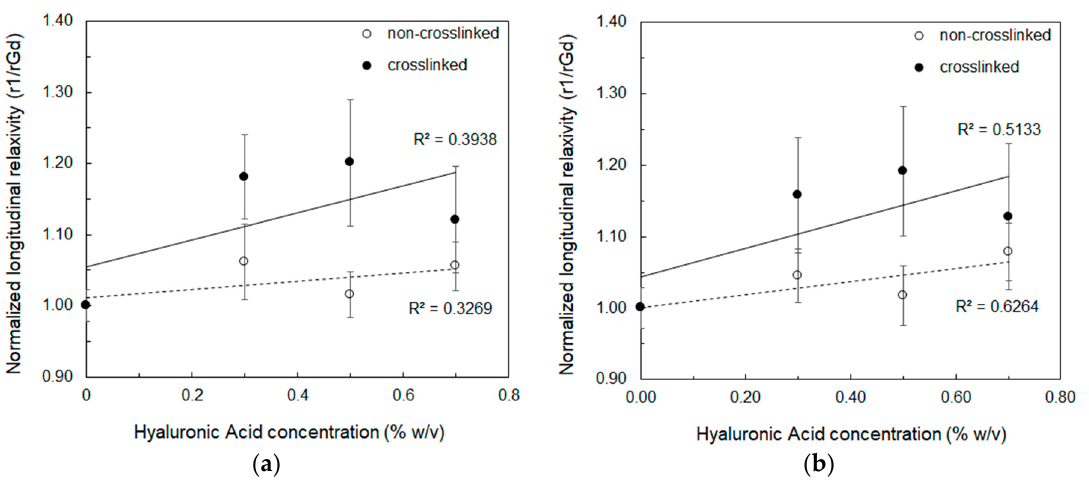
Figure 3. Longitudinal relaxivity (r1) for crosslinked (filled circles) and non-crosslinked (empty circles) samples with addition of Gd-DTPA, normalized against the relaxivity of free Gd-DTPA (rGd), as a function of the HA concentration measured at 60 MHz using: ( a ) Saturation Recovery sequence; ( b ) Inversion Recovery sequence. Linear regression lines with values of the determination coe ffi cients are